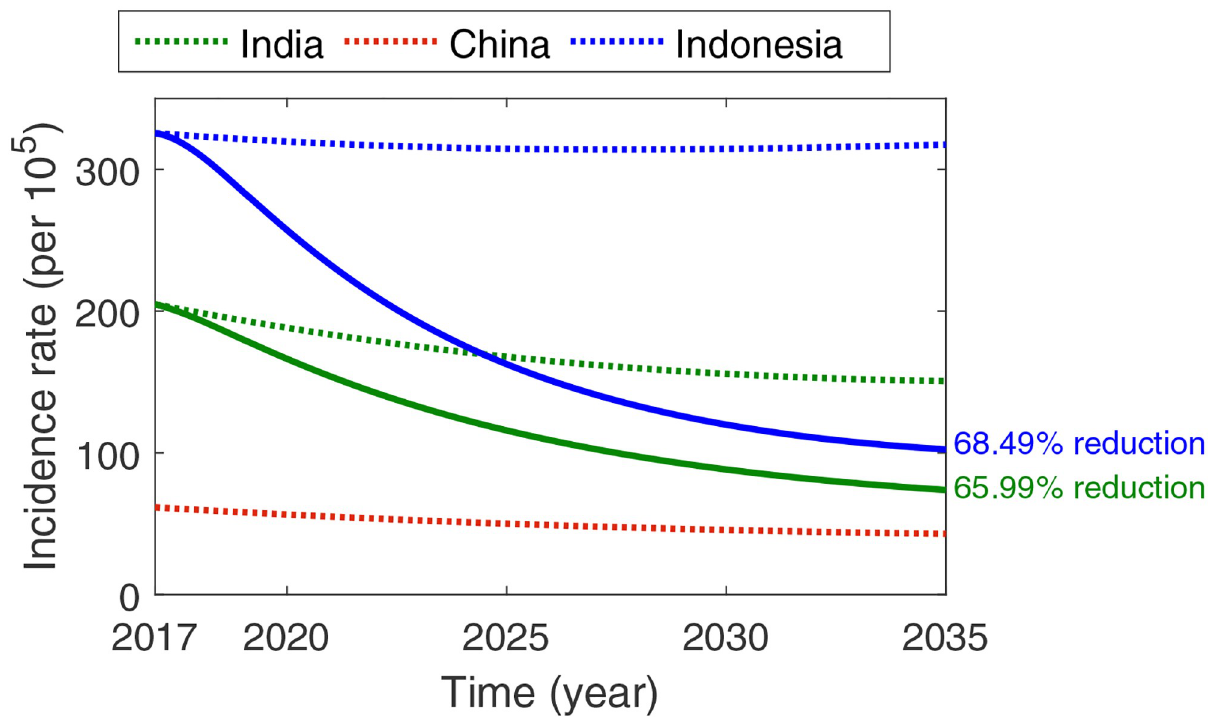
Fig 5. C 3: Constant case holding and active case finding control strategies in India and Indonesia. The likely percentage reductions in the TB incidence rate are 65.99% and 68.49% in India and Indonesia, respectively. Note that no control strategy is applied in China.